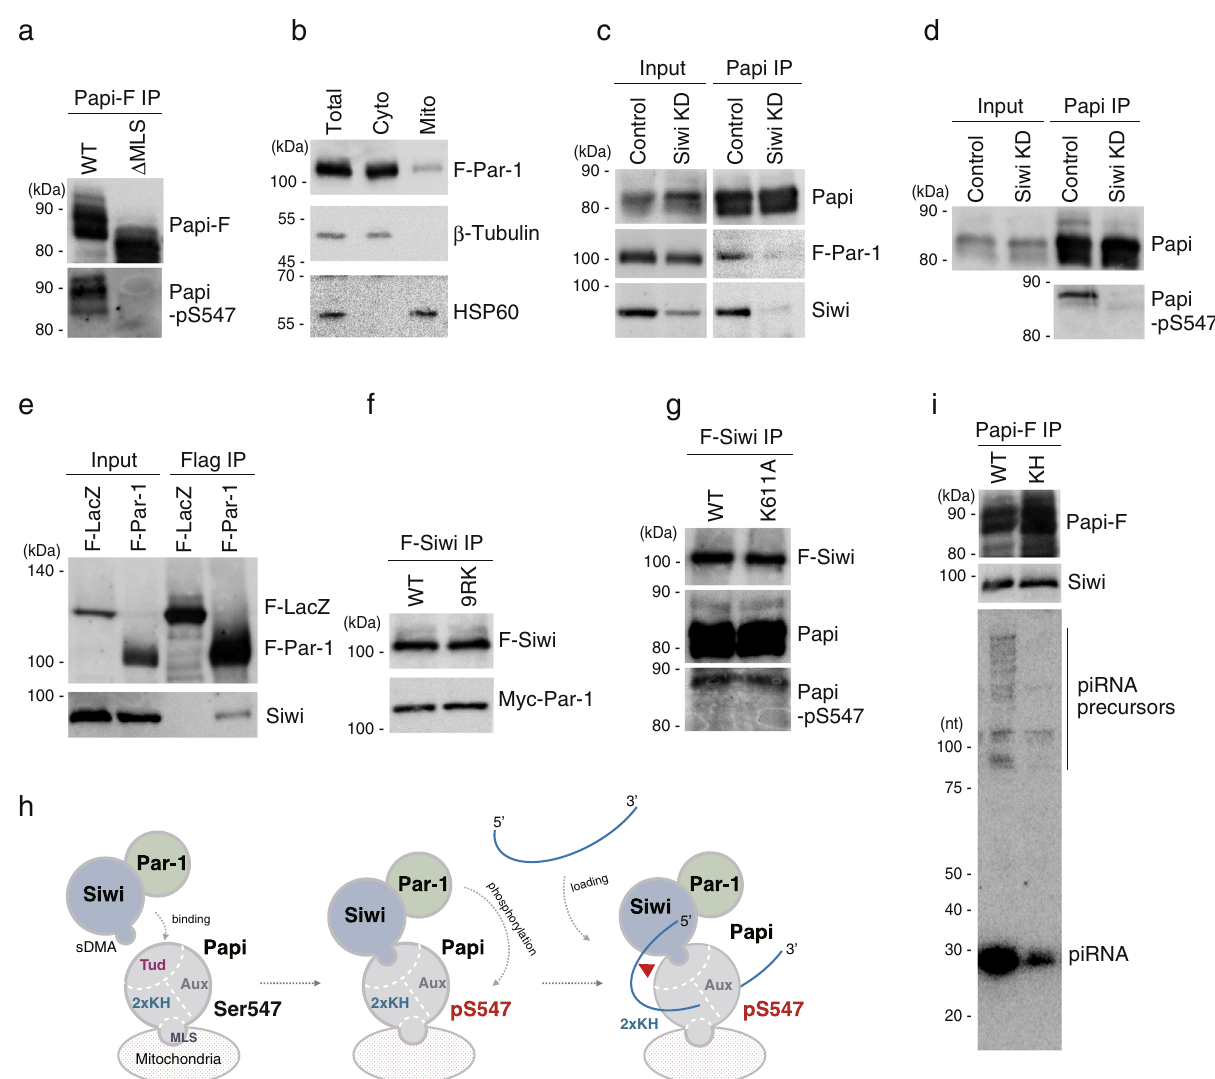
Fig. 3 Siwi targets cytoplasmic Par-1 kinase to mitochondrial Papi for its phosphorylation. a Western blotting shows that Ser547 of WT Papi is phosphorylated, whereas Ser547 of the Papi Δ MLS mutant is not ( n = 3). Anti-Papi (upper) and anti-Papi-pSer547 (lower) antibodies were used. Immunoprecipitation (IP) was performed using anti-Flag antibody. b Western blotting shows that Flag-Par-1 (F-Par-1) is concentrated in cytoplasmic (Cyto) but not in mitochondrial (Mito) fraction ( n = 3). β -Tubulin and HSP60 were used as markers of the cytoplasmic fraction and the mitochondrial fraction, respectively. c Flag-Par-1 (F-Par-1) and Siwi co-immunoprecipitated with Papi from normal BmN4 cell lysates (Control) but not from Siwi-lacking lysates (Siwi KD) ( n = 3). The cell lysates contained both cytoplasmic and mitochondrial materials. d Papi immunoisolated from normal BmN4 cell lysates (Control) was phosphorylated at Ser547, whereas Papi immunoisolated from Siwi-lacking lysates (Siwi KD) was not ( n = 3). Anti-Papi (upper) and anti- Papi-pSer547 (lower) antibodies were used. e Flag-Par-1 (F-Par-1) interacted with Siwi in BmN4 cytoplasmic lysates ( n = 3). The lysates did not contain mitochondrial materials. Flag-LacZ (F-LacZ) was used as a negative control. f Immunoprecipitation and western blotting show that the Siwi 9RK mutant binds to Par-1 similarly to WT Siwi ( n = 3). g Papi interacting with WT Siwi and the Siwi K611A mutant on the mitochondrial surface was similarly phosphorylated at Ser547 ( n = 3). Immunoprecipitation was conducted from the mitochondrial fraction. h Proposed model showing that Siwi binds Par-1 kinase in the cytosol and targets it to mitochondrial Papi. Papi binds symmetrical dimethylarginine-modi fi ed Siwi via the Tudor domain. Par-1 then phosphorylates Ser547 of Papi. Papi then binds Siwi-loaded piRNA precursor via the KH domains for Zuc-mediated piRISC maturation (red triangle). The Siwi 9RK mutant cannot bind to Papi and hardly bound to piRNA precursor 14 . Thus, Siwi was loaded with piRNA precursor after its anchoring onto Papi. i Western blotting (upper two) shows that endogenous Siwi bound the KH mutant of Papi as it does to WT Papi ( n = 3). Northern blotting (lowest) shows that piRNA precursors and piRNAs were barely found in the Papi KH mutant-Siwi complex (also see Supplementary Fig. 3). Source data are provided as a Source Data fi